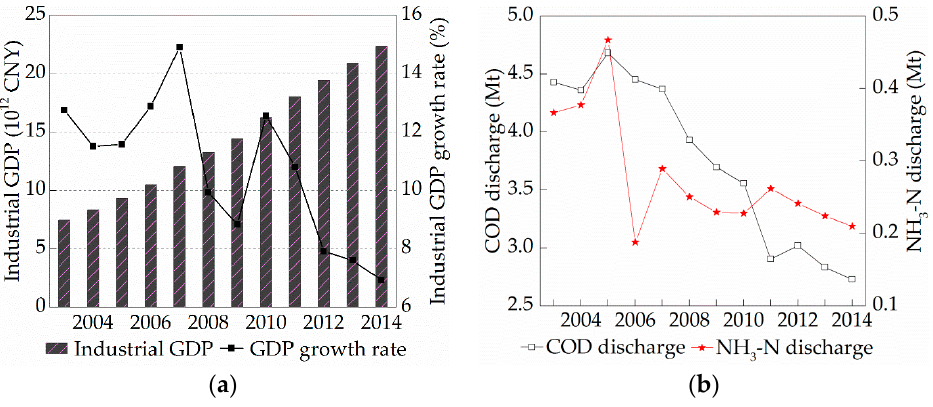
Figure 1. Changes in the industrial GDP (containing the corresponding growth rates) and the dynamics of the two discharges (COD and NH 3 -N) during the 2003–2014 period in China. ( a ) GDP and ( b ) Discharges.